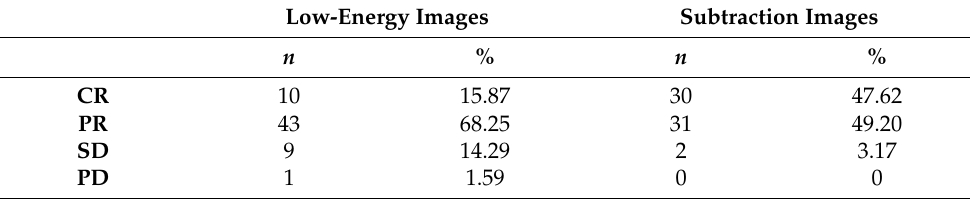
Figure 2. Correlations between: ( A ) the maximum tumor sizes after NAC in low-energy CESM images and in histopathology results: R = 0.26, p < 0.04; ( B ) the maximum tumor sizes after NAC in low-energy CESM images and in histopathology results: R = 0.67, p < 0.01. Table 3. Individual therapeutic responses to NAC using low-energy and subtraction CESM